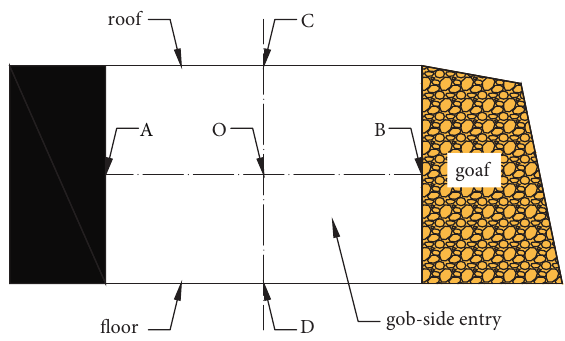
Figure 10: Measuring-point arrangement of surface